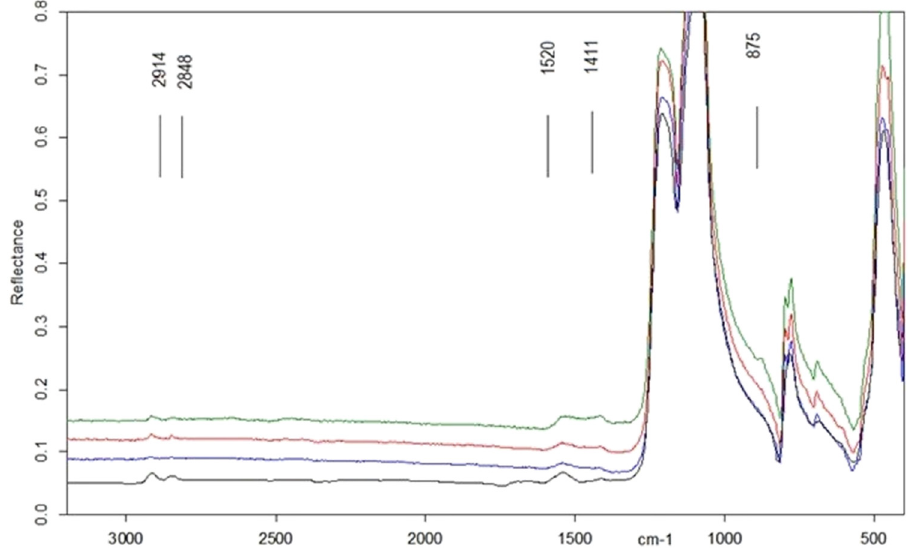
Figure 12: Micro FTIR spectrum of dorsal and ventral points of a fl ake from building 35 ( FTIR spectra by S. Nunziante Cesaro )